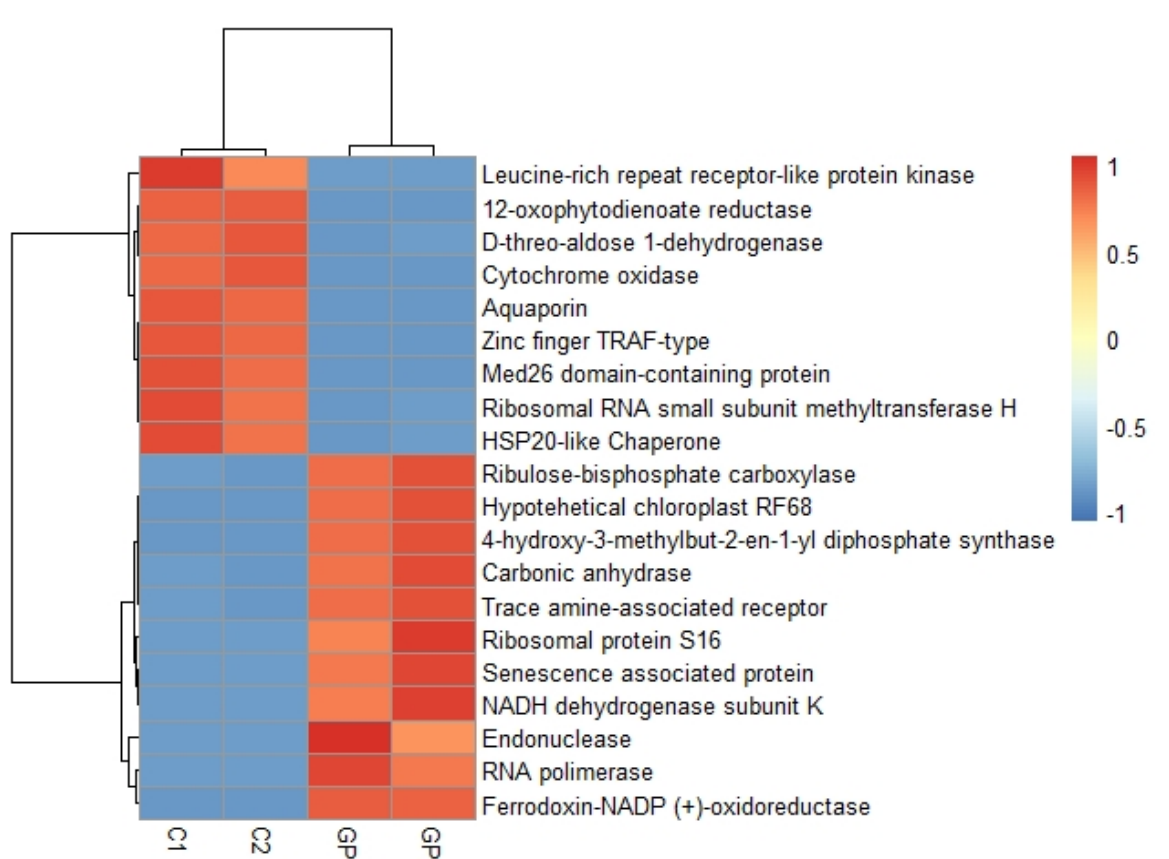
Table 2. Annotation and gene counts of transcripts related to terpene synthesis of two populations of Galphimia spp.